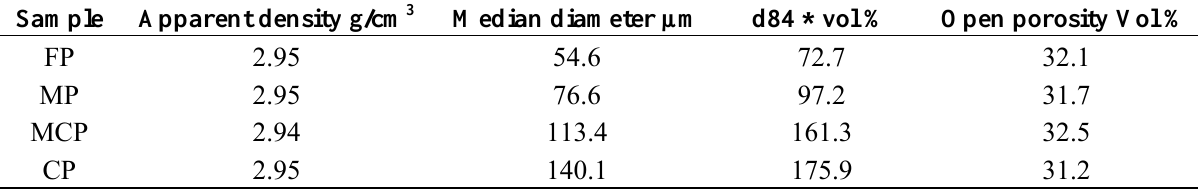
Table 2. Porosimetry test results.